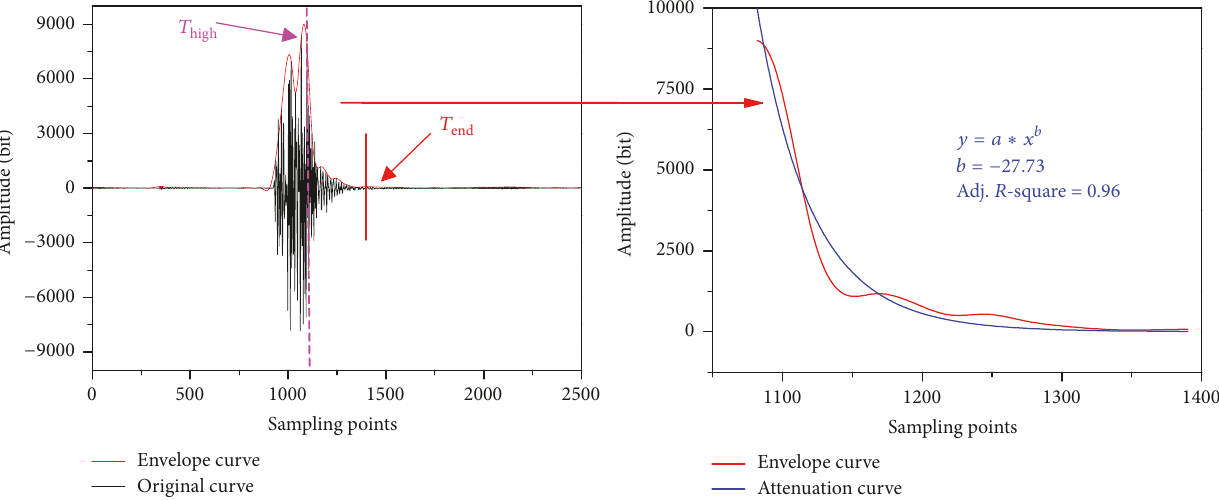
Figure 6: Envelope curve and following peak attenuation curve of a coal mining MS signal.